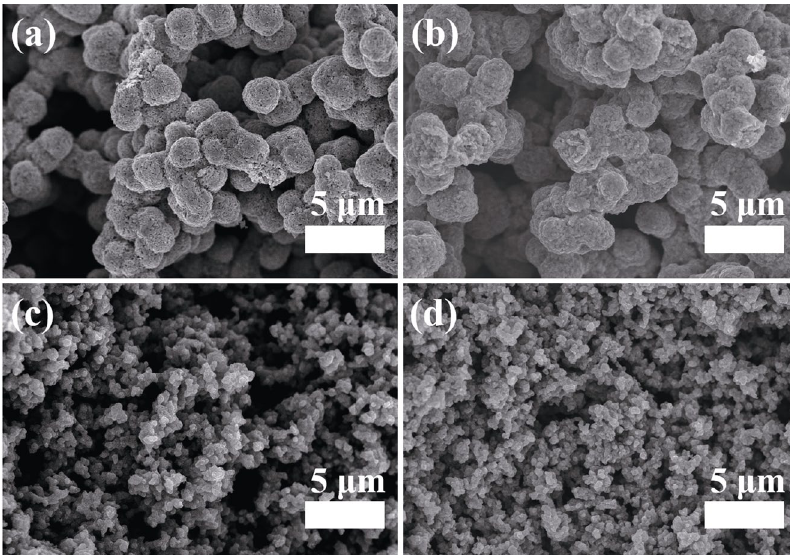
Fig. 14 SEM images of the porous ZrB 2 /ZrC/SiC ceramics via solvent evaporation method before and after thermal aging at 2000 ℃ for 1 h [22]. Reproduced with permission from Ref. [22], © Elsevier Ltd.